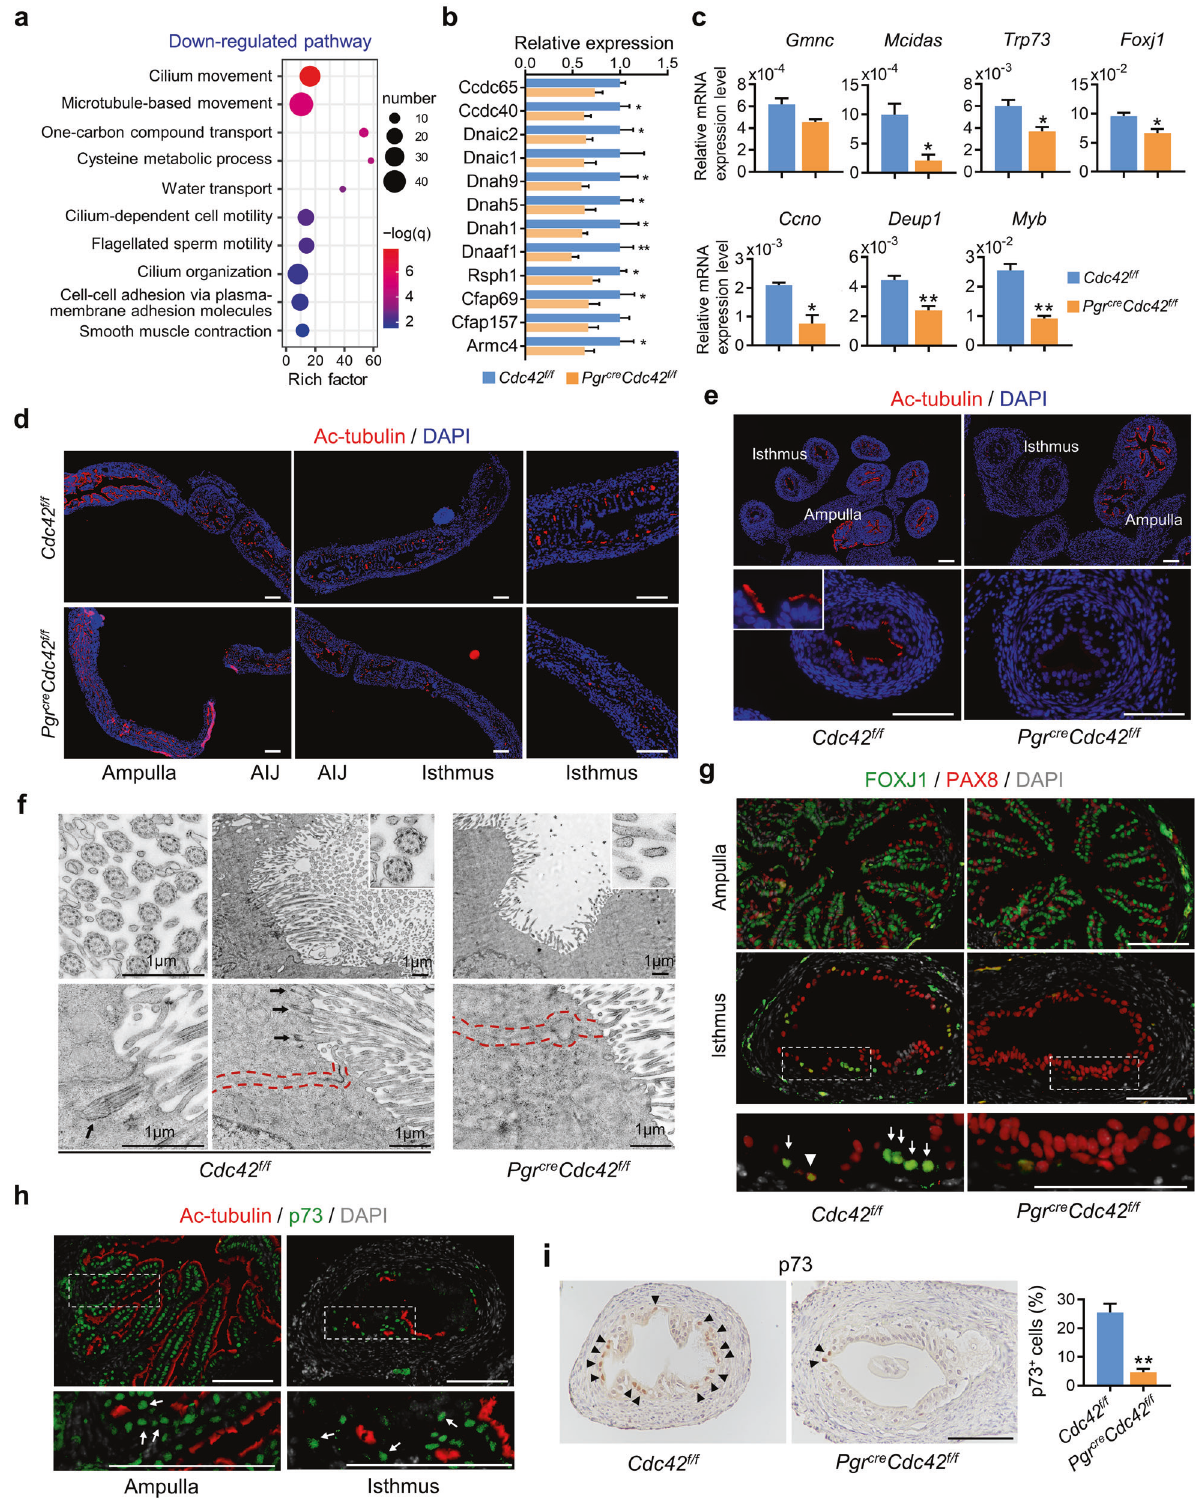
fate commitment by p73 (Fig. 2h). However, the ratio of p73 positive cells was signi fi cantly reduced in the oviductal isthmus of Pgr cre Cdc42 f/f mice (Fig. 2i). All the above data indicated that reduced multiciliated cells number in the oviductal isthmus of CDC42 de fi cient mice resulted from the impaired multiciliogen- esis regulatory network and multiciliated cells